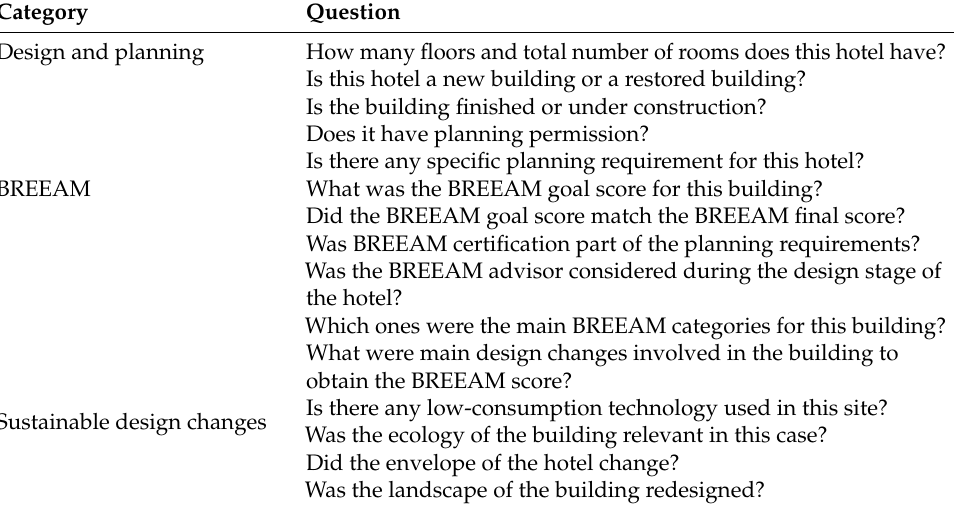
Table 1. Main Questions.